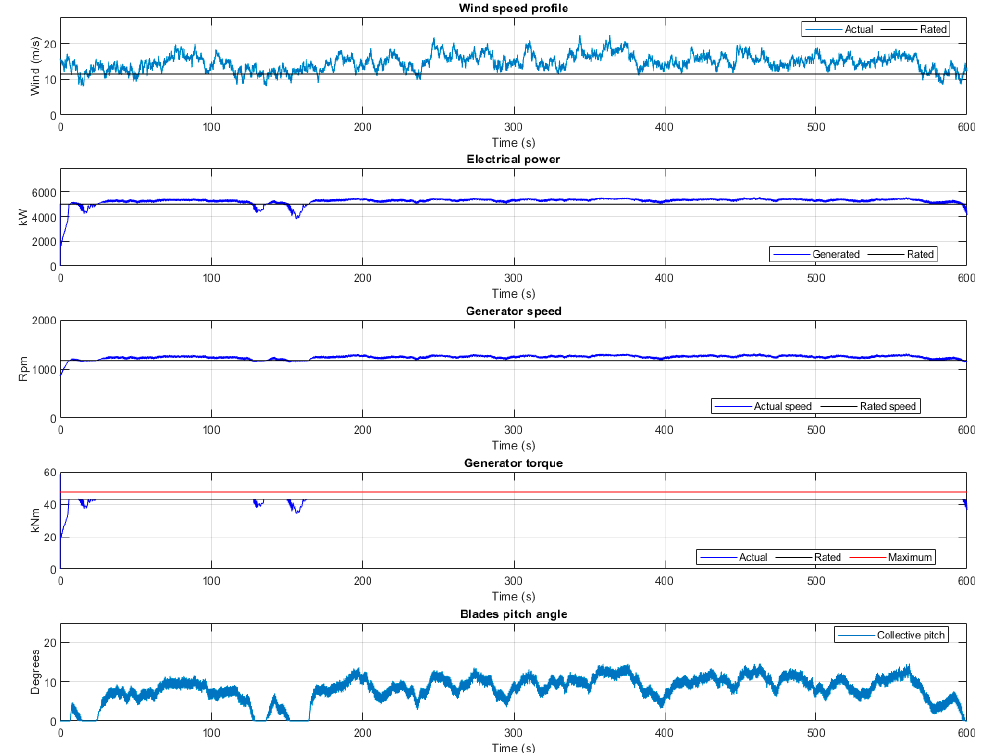
Figure 9. Simulation for reference PI with the Fuzzy Supervisor Control, under a wind profile of average speed of 15 m/s and turbulence A.